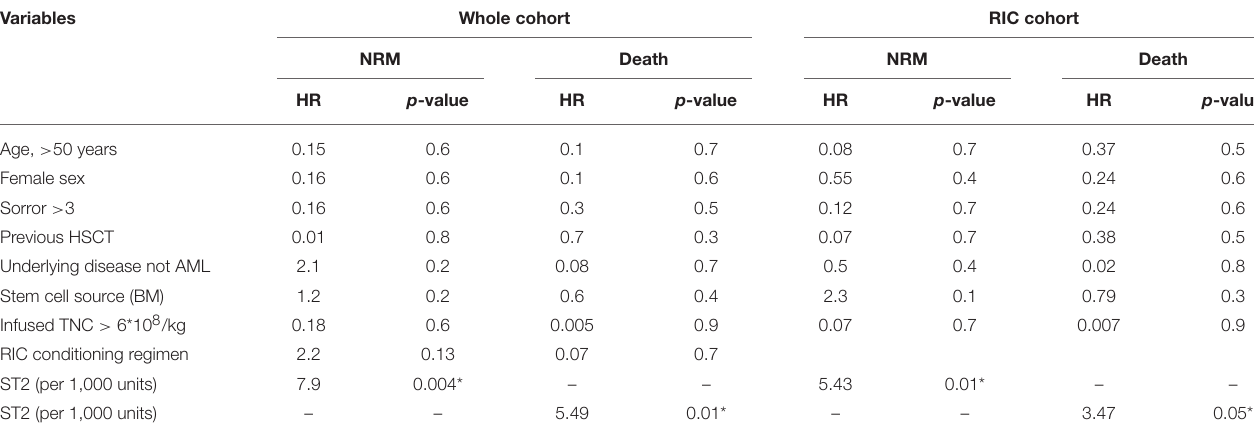
TABLE 4 | Association between ST2 levels at day + 30, clinical variables and cumulative incidence of NRM and death in the whole cohort ( n = 87) and the RIC cohort ( n = 52). Variables